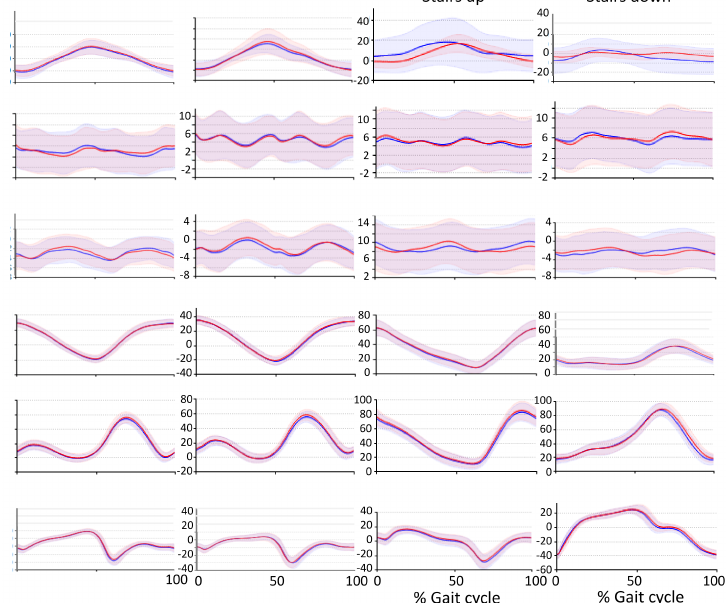
Figure 3. Group average joint angular curves, constructed from each participant’s mean curve during comfortable gait, fast gait, and stair walking. Data were time-normalized over each gait cycle (i.e., the time sequence between two successive events). The figure shows sagittal plane movement, i.e., shoulder, thorax, hip, and knee flexion-extension, pelvis anterior-posterior tilt, and foot dorsiflexion-plantarflexion. Blue curves represent angular movement during right-sided (dominant) gait cycles and red curves represent angular movement during left-sided (non-dominant) gait cycles. The right leg and arm are displayed for right-sided gait cycles, and vice versa. Shaded areas represent the group standard